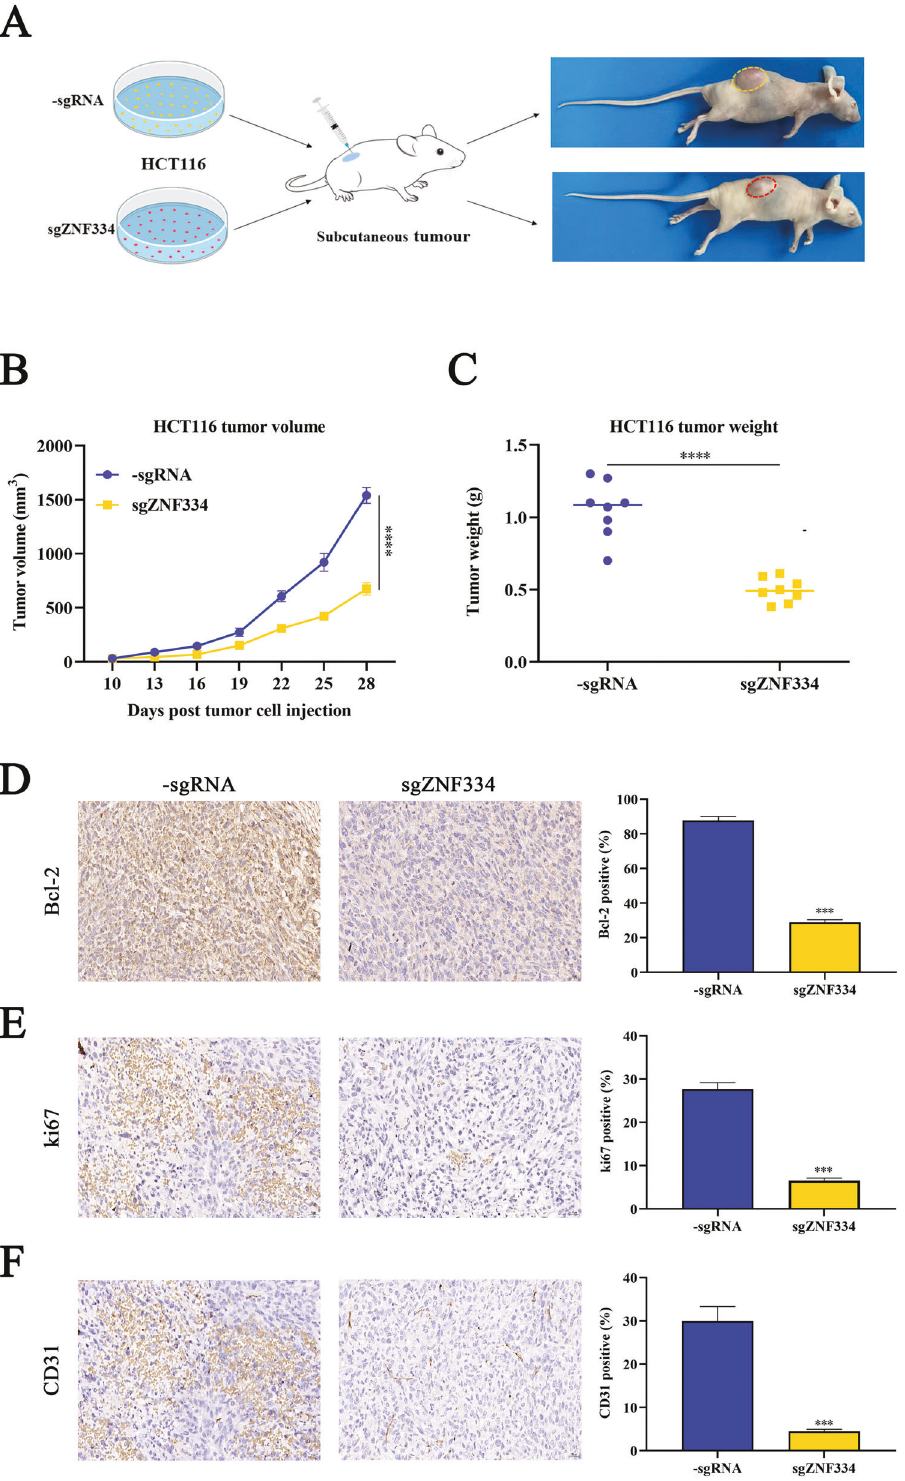
Fig. 5 The targeted demethylation of ZNF334 suppresses HCT116 cell tumor growth in CRC xenograft mice. A The diagram of the antitumor effect of the targeted demethylation of ZNF334 in vivo. B , C Tumor volume and end-stage tumor weight after the injection of HCT116 cells stably transfected with dCas9-multiGCN4/scFv-TET1CD-sgRNA and dCas9-multiGCN4/scFv-TET1CDsgZNF334 ( n = 8, **** p < 0.0001, compared with the sgRNA group). D – F Immunohistochemical staining assay detected the apoptosis and proliferation in the tumor tissues, and the percentages of Bcl-2, Ki67, and CD31-positive cells were analyzed ( n = 3, Scale bar = 20 μ m, *** P < 0.001, compared with the sgRNA group).